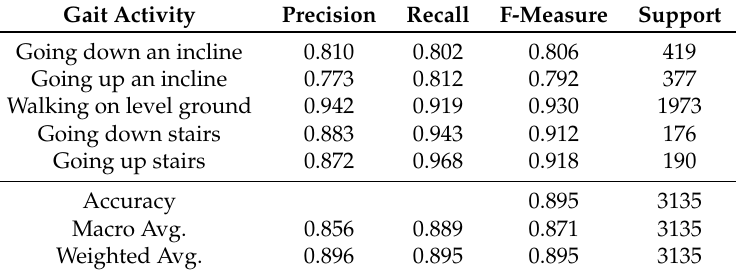
Table 7. Classification report of the CNN model trained with the unbalanced dataset.